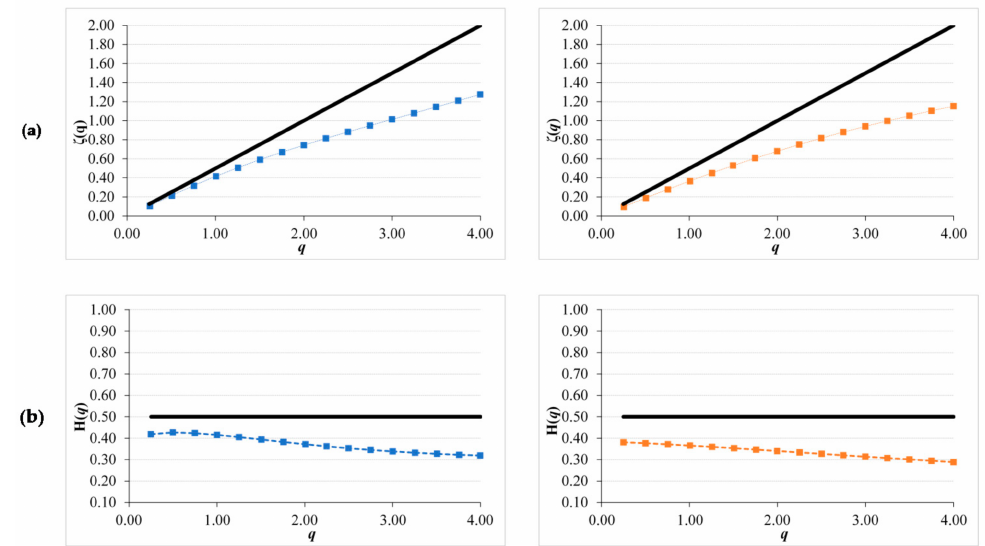
Figure 10. Generalized Structure Function plots for NDVI anomaly series of SOM5 (left column in blue) and SOM15 (right column in red) for: ( a ) ζ ( q ) curve and ( b ) Generalized Hurst exponent H( q ), continuous line correspond to non-correlated noise with Hurst value of